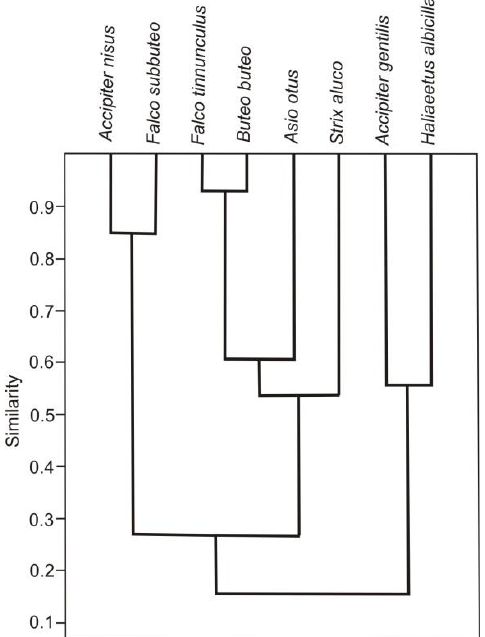
Figure 2. Cluster analysis based on the unweighted pair-group average (UPGMA) and Morisita’s Index of Similarity, which estimates the similarity in the diet composition between avian predators in the breeding season in the area of study (central Poland, vicinity of Rogów village, Experimental Forest Station of Warsaw University of Life Sciences), based on pellet analysis and prey remains collection.